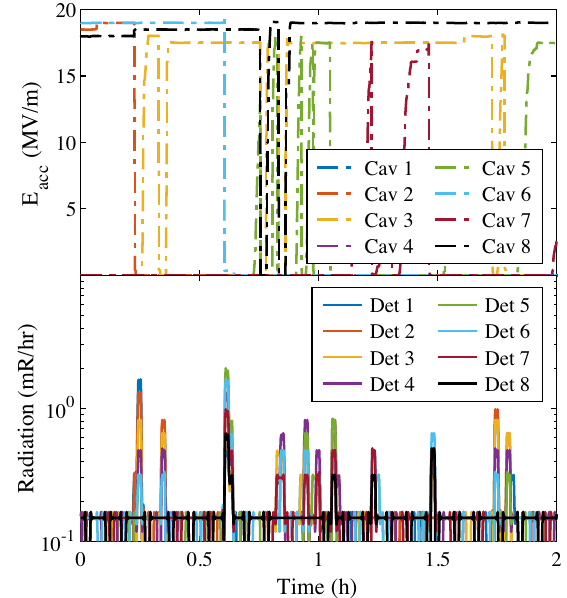
FIG. 5. A strong correlation was observed between quenching (appearing in the top plot as a sudden drop in gradient) and bursts of x rays as observed with radiation detectors located alongside the cryomodule (bottom plot). The data are from Fermilab cryomodule 16 in the L2 production series.